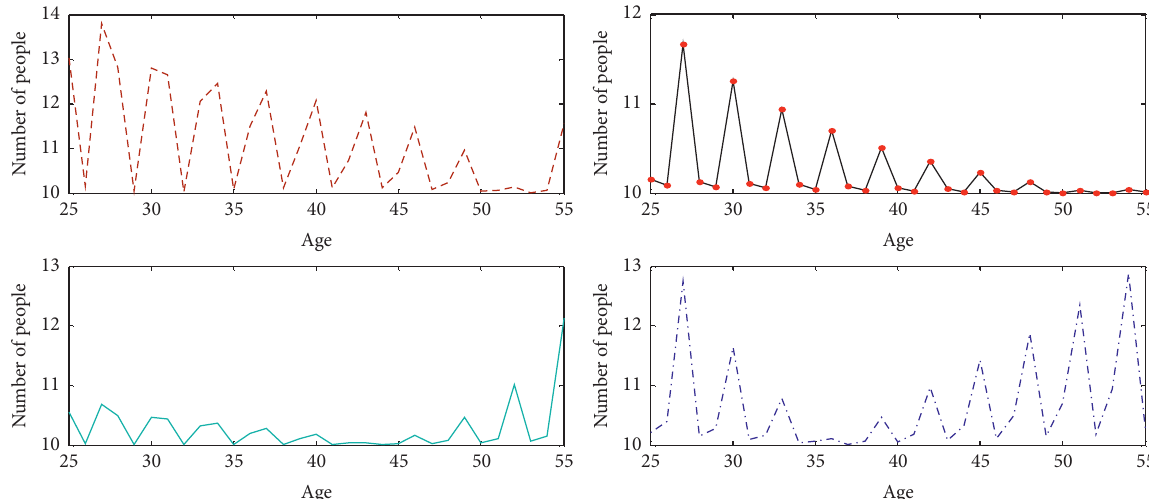
Figure 5: The age structure of physical education teachers in four